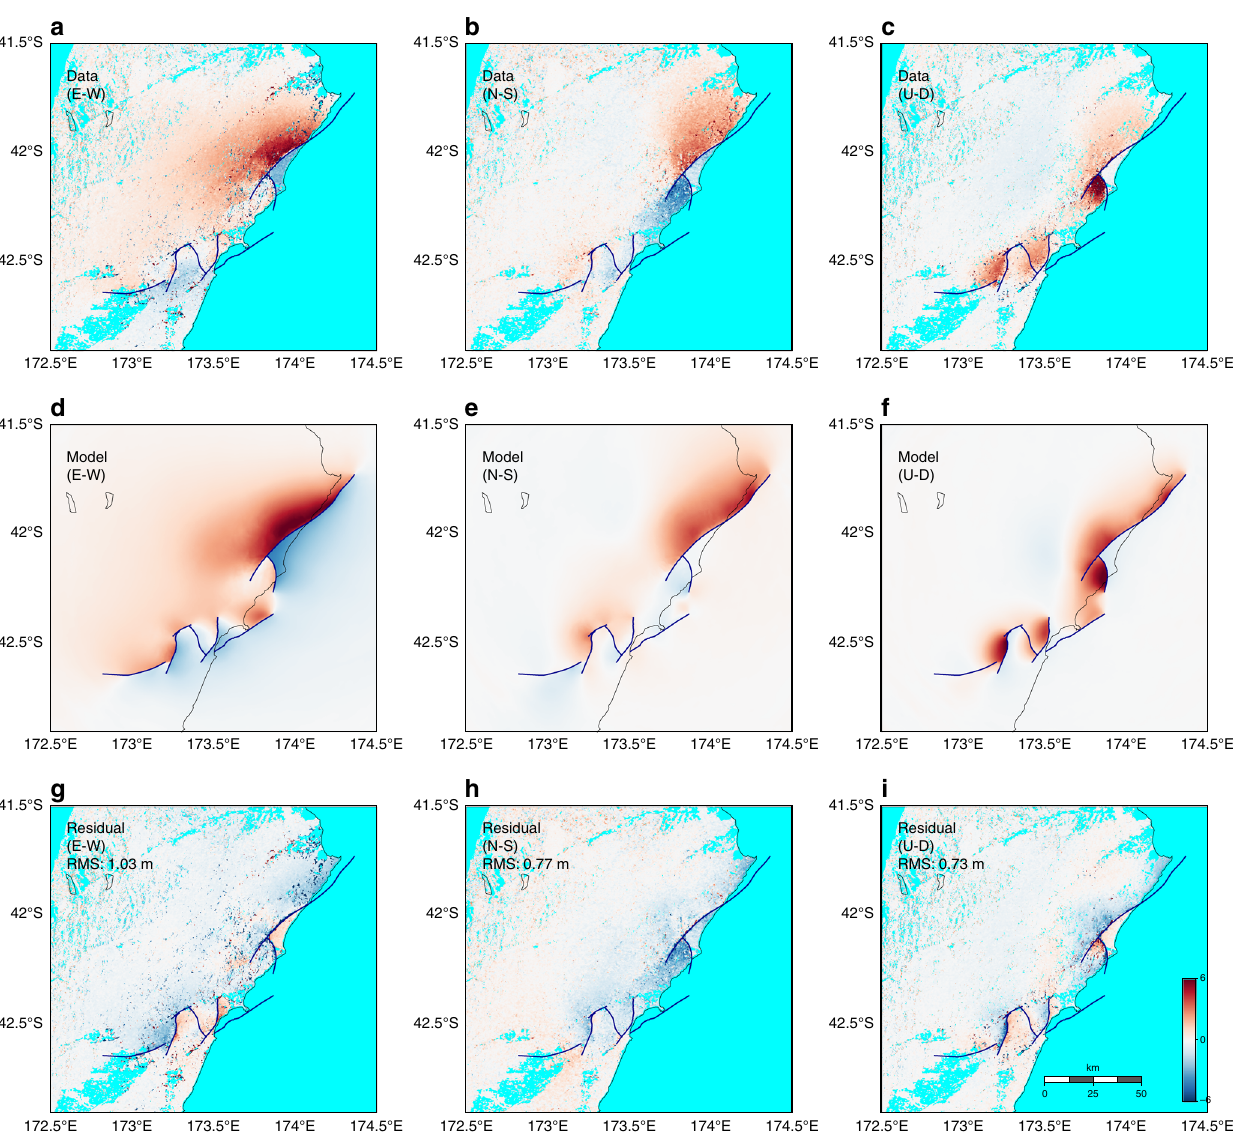
Fig. 6 Comparison of observed and modeled co-seismic surface displacements. Three-dimensional (3D) ground displacement ( fi rst row, a – c ) inferred by space geodetic data 7 , (second row, d – f ) generated by the dynamic rupture model and (third row, g – i ) their difference, all in meters. Columns from left to right are EW, NS, and UD components. Root-mean-square (RMS) mis fi ts are provided in the third row for each